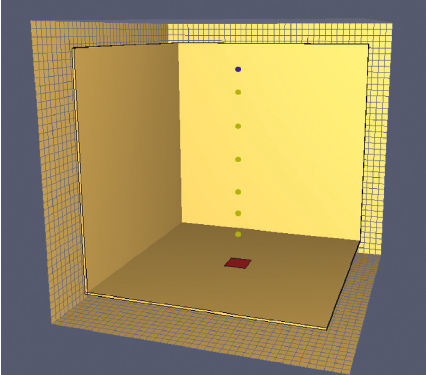
Figure 6: Fire model. The bottom square in the figure is where the fire source is placed, and 6 thermocouples are placed directly above the fire source. The distance of the thermocouple from the lower fire source is 0.25m, 0.35m, 0.45m, 0.6m, 0.75 m, and 0.9m, respectively. Figure 7: Temperature field in the simulation experiment.